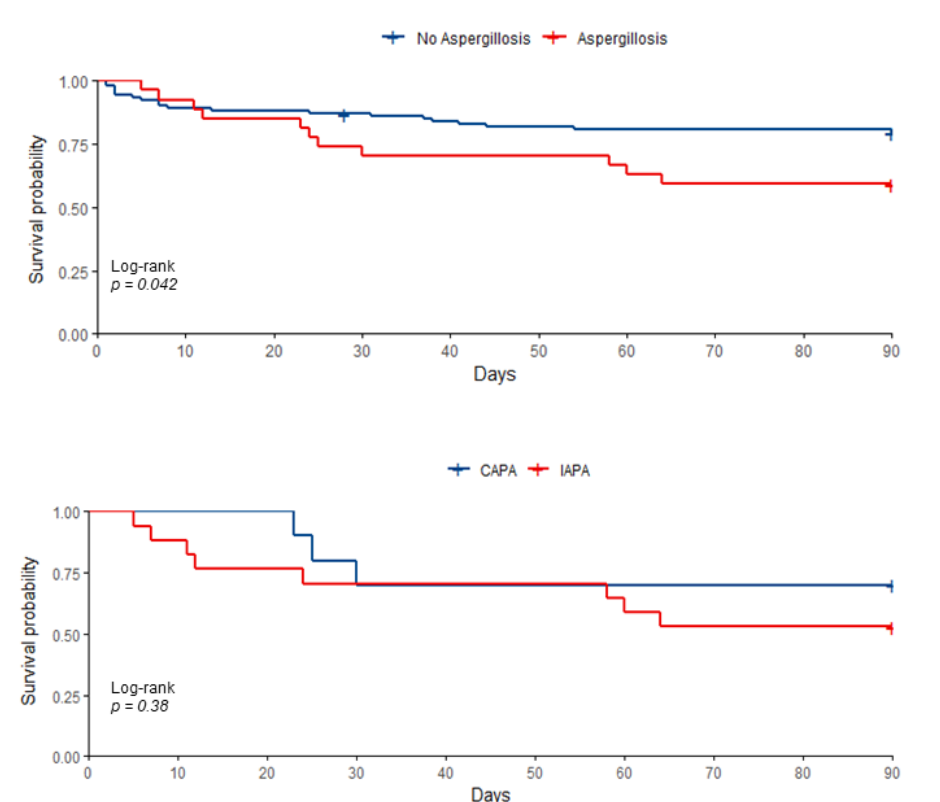
Figure 1. Cumulative 90-day mortality from admission to the intensive care unit in the whole population ( A ) and among CAPA and IAPA patients ( B ).